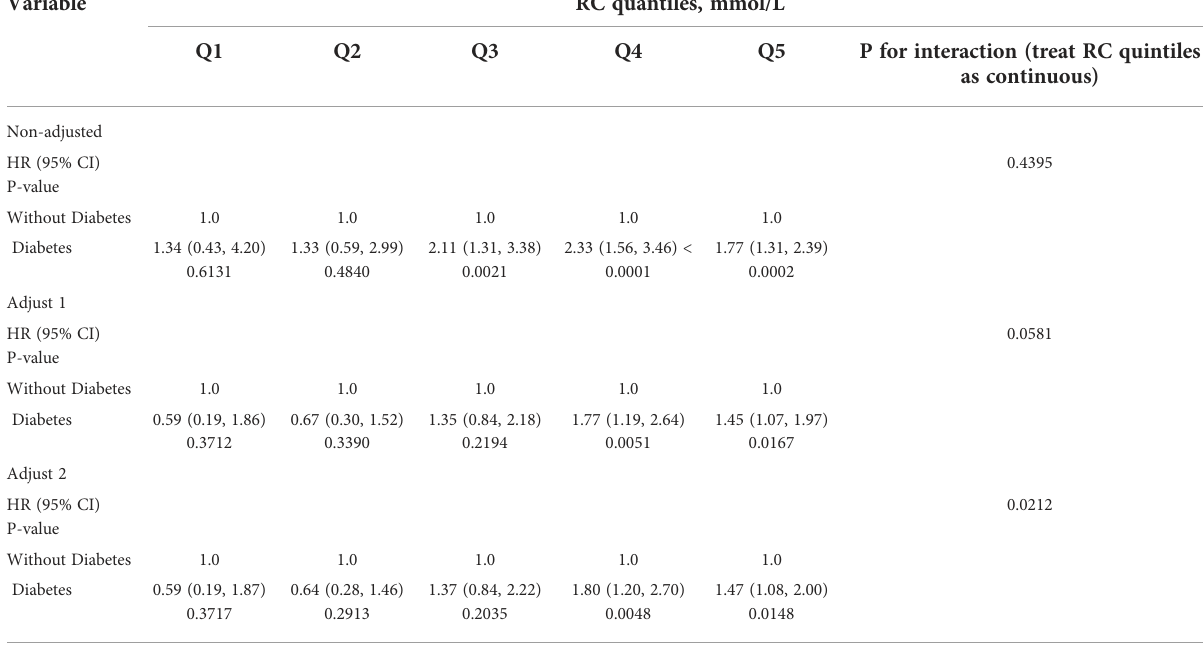
TABLE 4 Association of diabetes with HTN incidence among participants with RC quintiles.